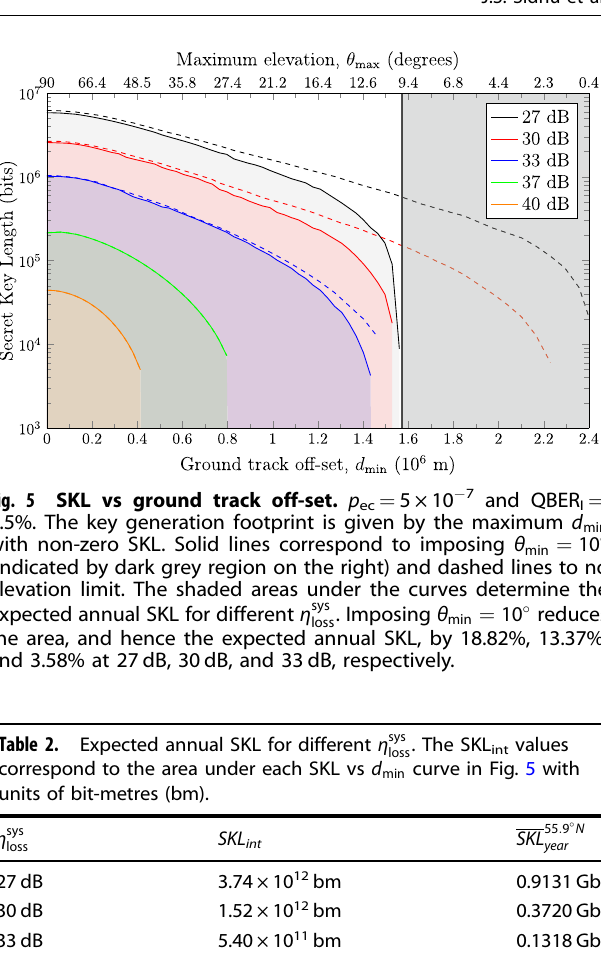
. The SKL int values loss